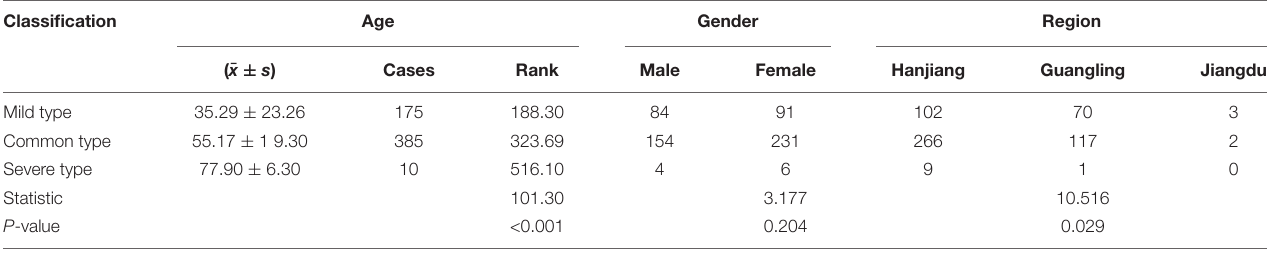
TABLE 1 | Differences in age, gender, and regional distribution of the confirmed COVID-19 patients with different disease types. Classification